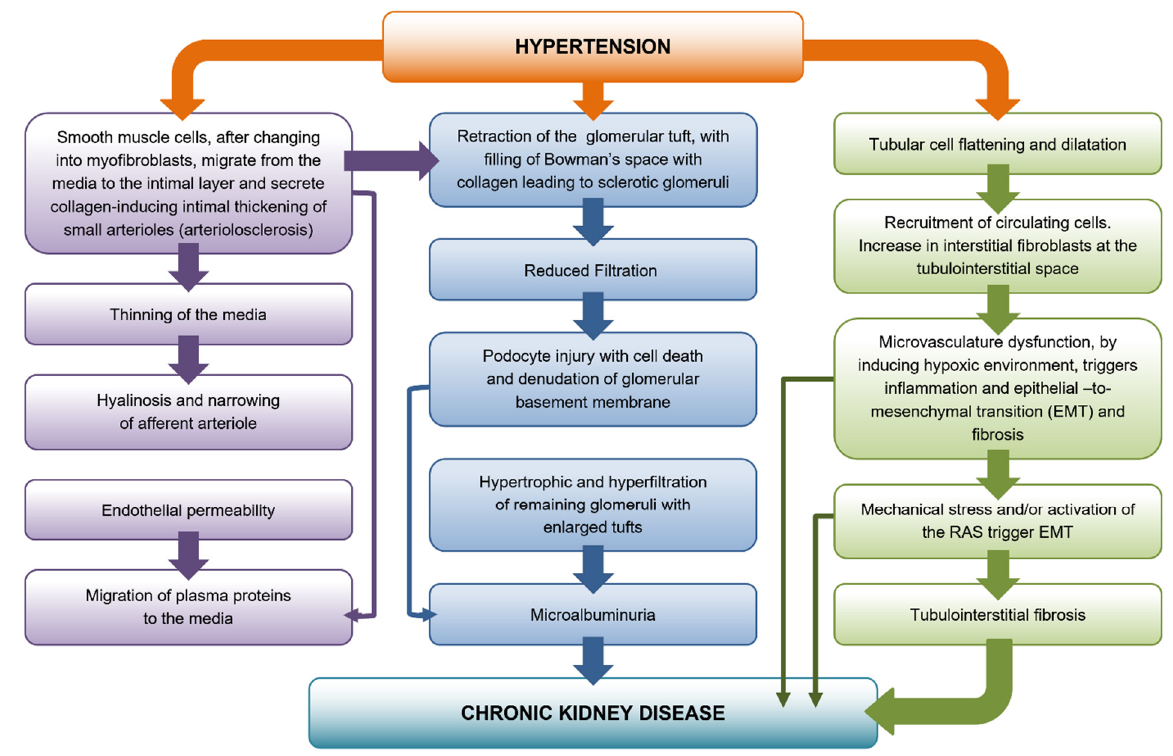
Figure 2. Histopathology and molecular mechanisms underlying nephropathy in primary (essential) hypertension. Modification in the vascular, glomerular and tubular compartments lead to the development of chronic kidney disease.